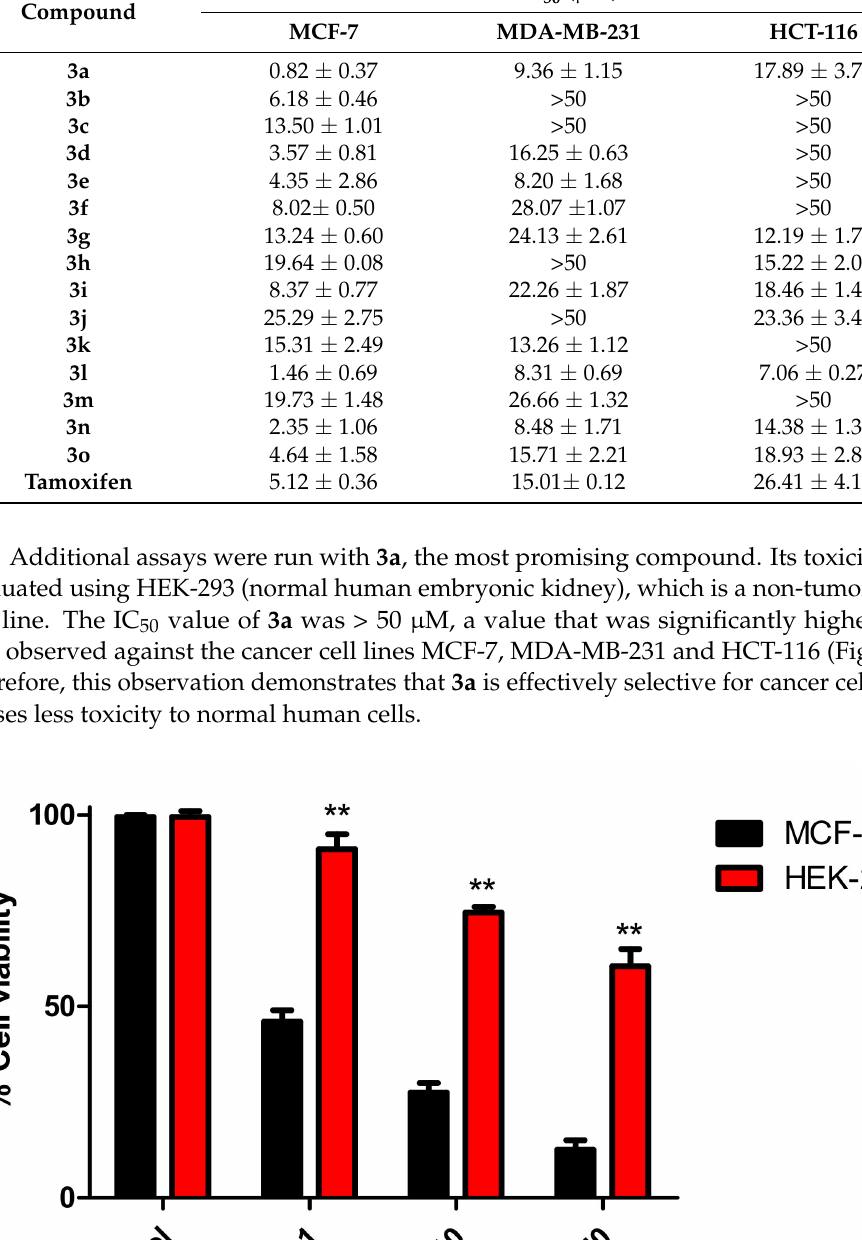
Table 1. Antiproliferative effects of 3a–o in MCF-7, MDA-MB-231 and HCT-116 cells. Compound